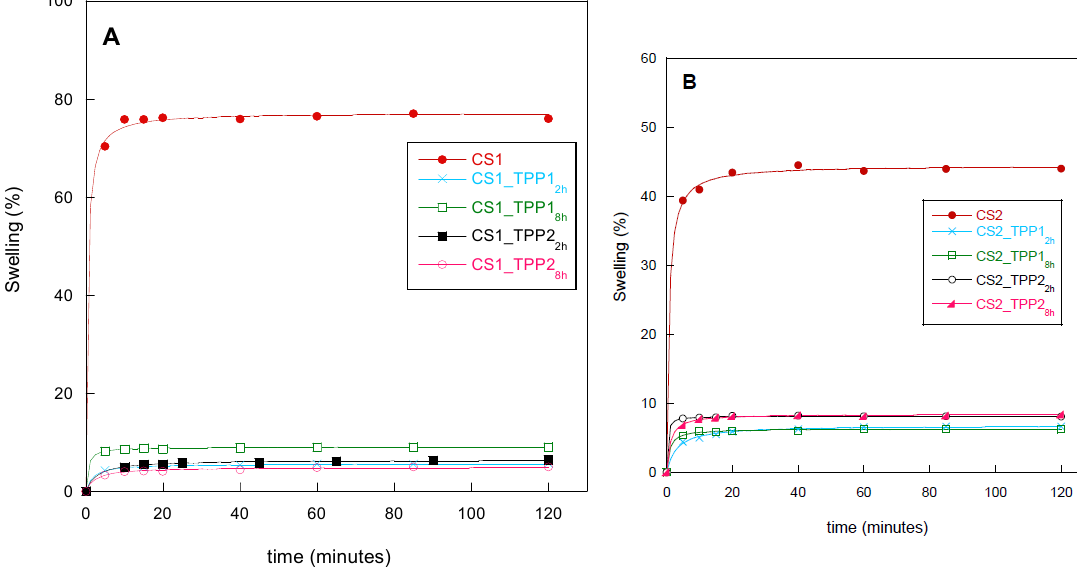
Figure 7. Swelling kinetics of the scaffolds obtained at different cross-linking conditions: ( A ) CS1 and CS1_TPP and ( B ) CS2 and CS2_TPP.